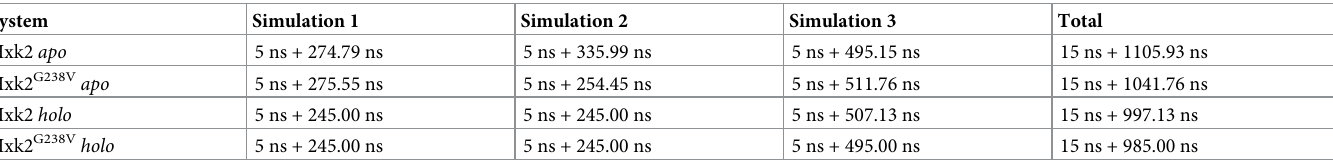
Table 5. Simulation